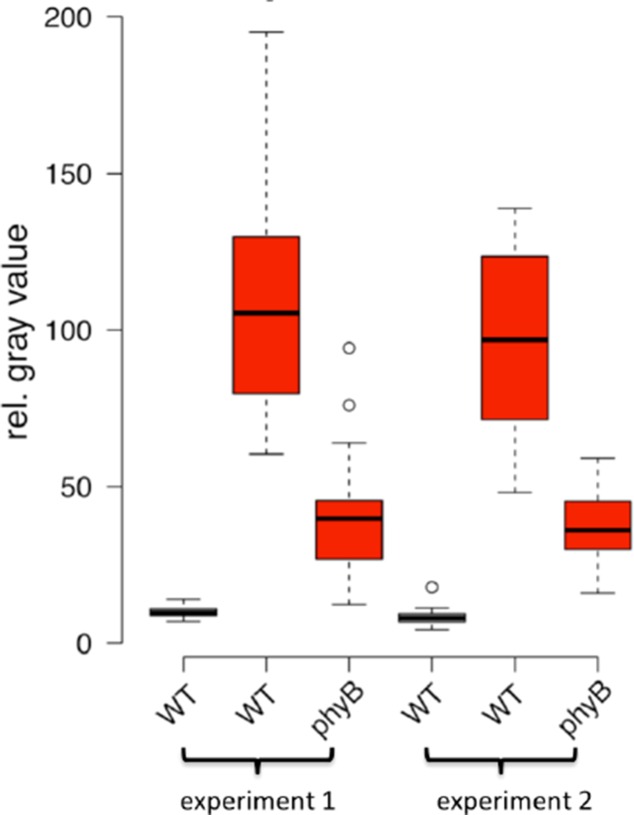
DOI:
http://dx.doi.org/10.7554/eLife.17023.019